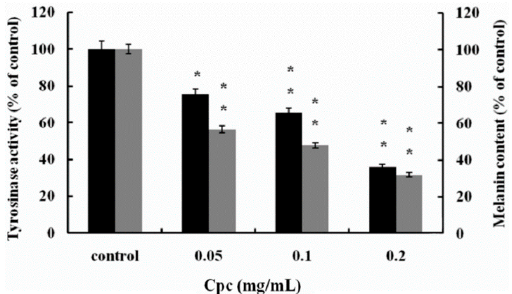
Figure 6. Effect of C-phycocyanin (Cpc) on tyrosinase activity (black) and melanin content (grey). The asterisk (*) has been used to denote a significant difference from control group (*, p < 0.05; **, p < 0.01). Published by Ref. [35].